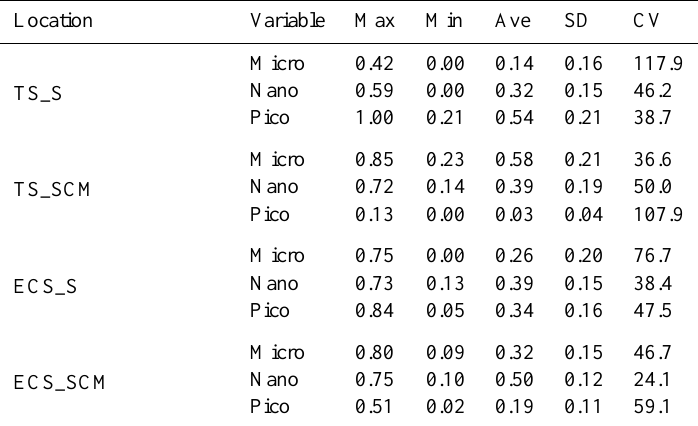
Table 2. Comparisons of Tchl a size-fractions of micro-, nano- and pico-phytoplankton in the Tsushima Strait surface (TS_S), Tsushima Strait SCM (TS_SCM), East China Sea surface (ECS_S), and East China Sea SCM (ECS_SCM). Max: maximum; Min: minimum; Ave: average; SD: standard deviation; CV: coefficient of